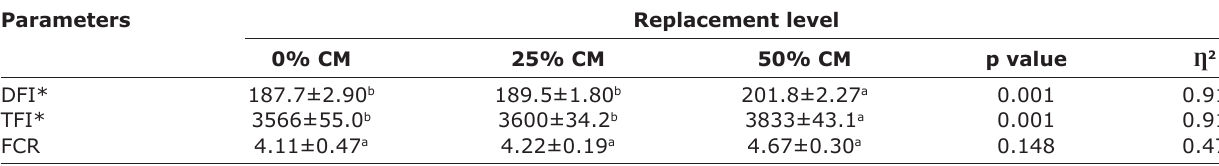
Table-4: Mean values on feed efficiency of finisher broilers fed with varying amounts of cocoyam meal as partial carbohydrate replacement for maize.